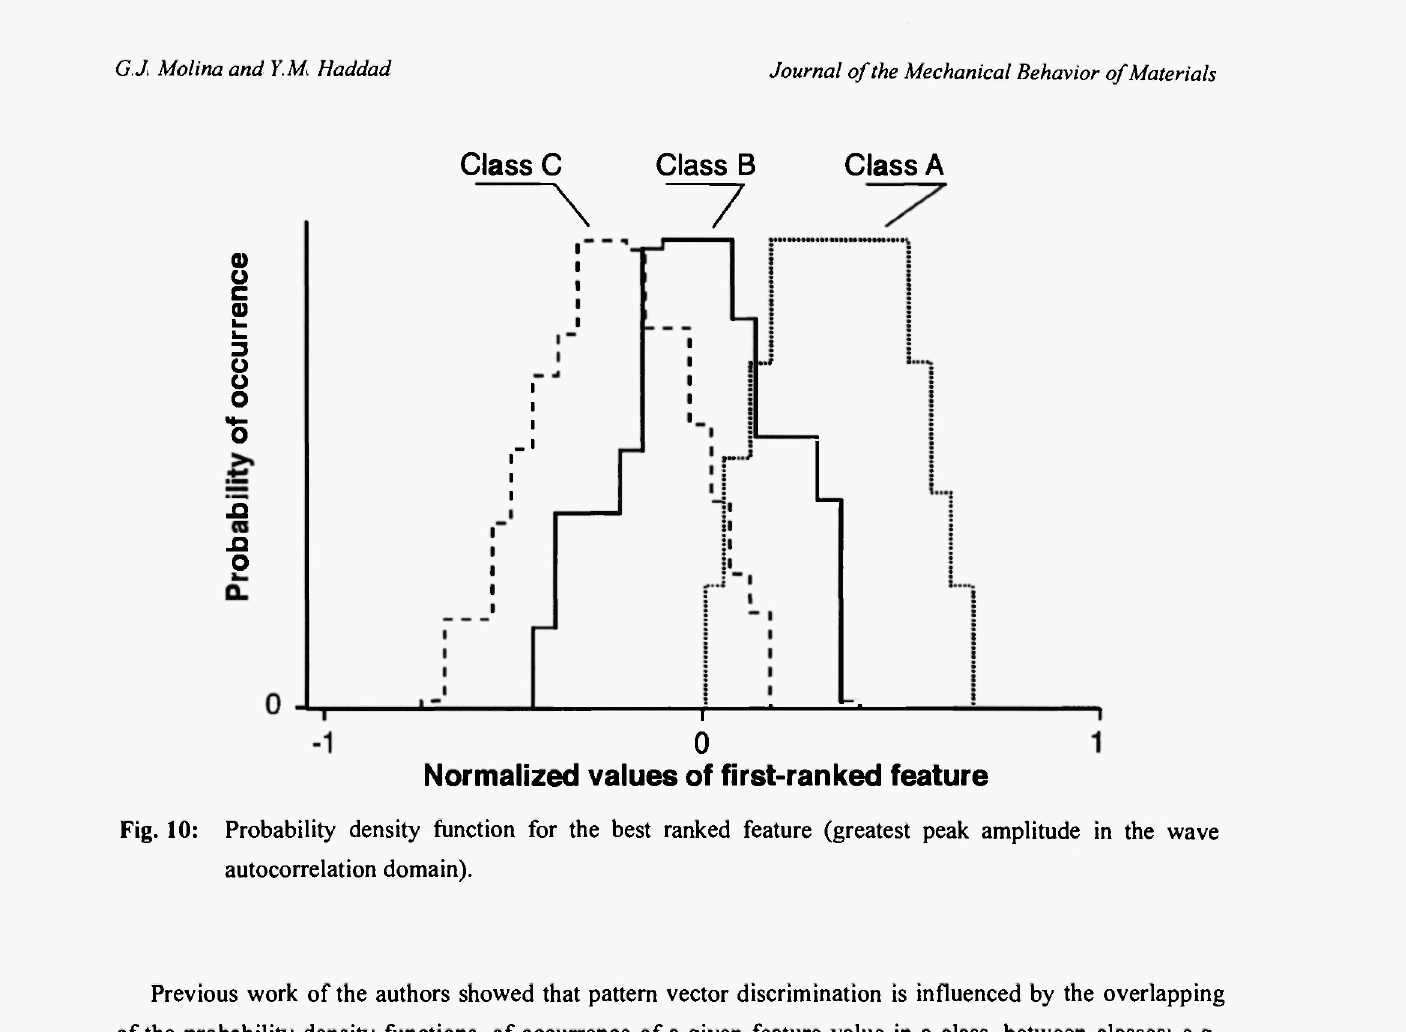
Fig. 10: Probability density function for the best ranked feature (greatest peak amplitude in the wave autocorrelation